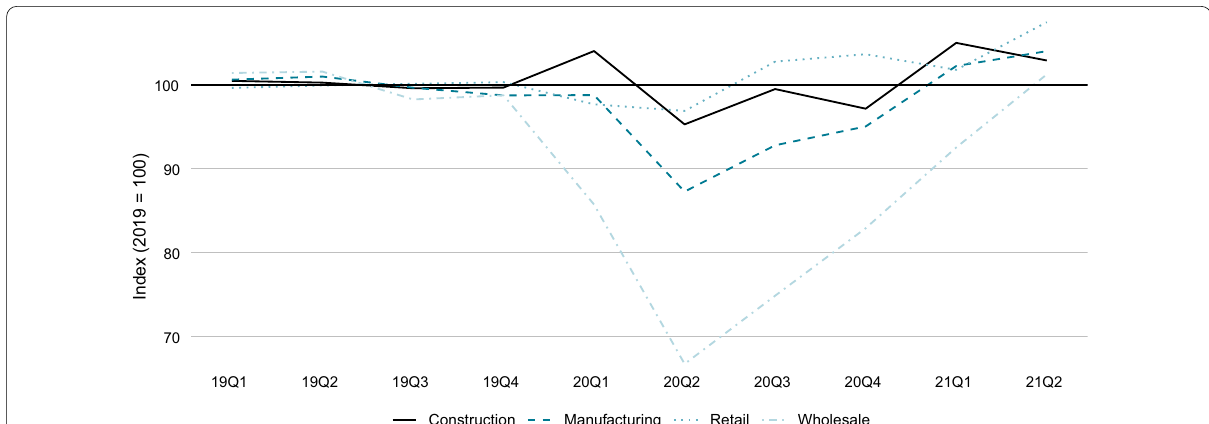
Fig. 2 Quarterly revenues in selected industries. Notes : The figure shows the seasonally adjusted revenues in selected industries as compiled by the Swiss Federal Statistical Office in the quarterly Industry Production, Orders and Turnover Statistics (INDPAU). The data is indexed such that the average of 2019 is equal to